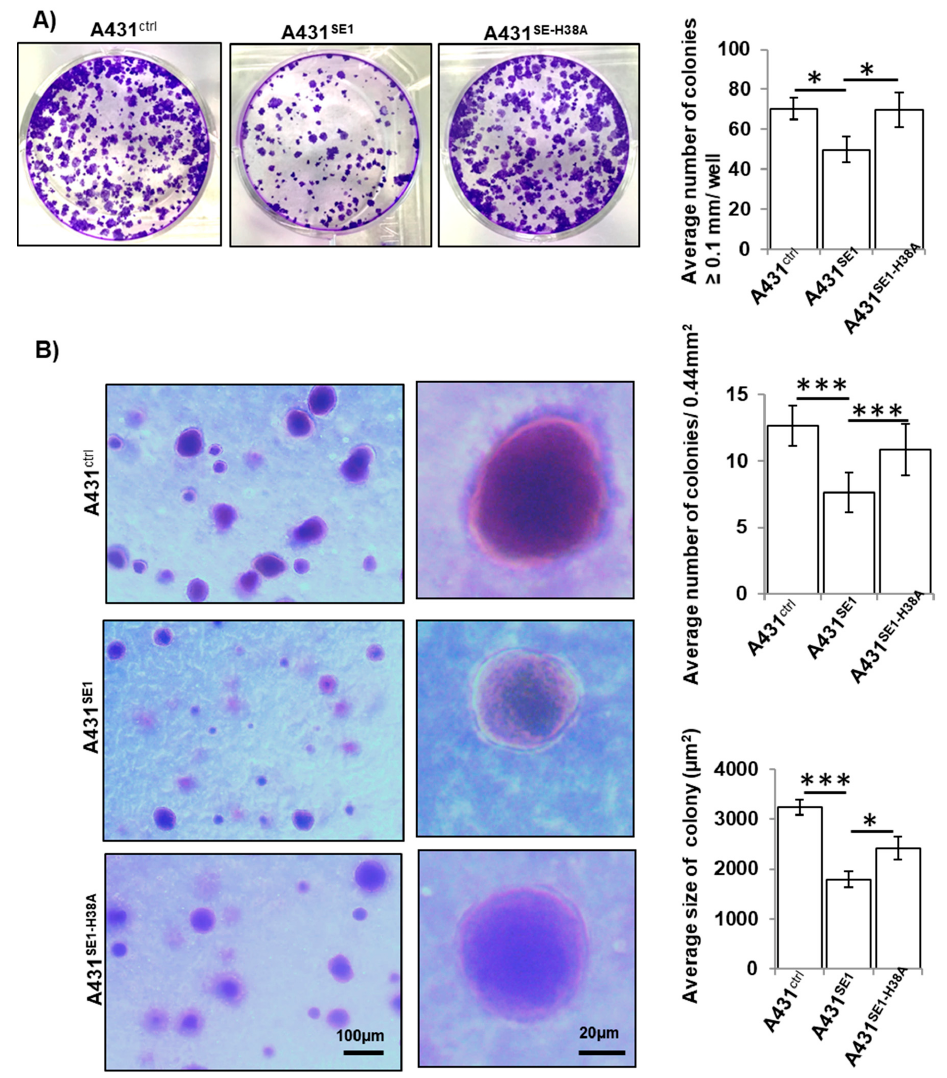
Figure 2. CDC42SE1 inhibits colony formation and growth of A431 cells in soft agar. ( A ) A431 cells (A431 Ctrl , A431 SE1 , and A431 SE1-H38A ) cells were grown for 14 days before being stained with 0.05% crystal violet and imaged. Graph represents the average number of colonies/well. ( B ) A431 cells (A431 Ctrl , A431 SE1 , and A431 SE1-H38A ) were grown in 0.6% agar for 14 days and stained with 0.05% crystal violet and imaged. Graph represents average the number of colonies/area and average size of colonies. Images were taken with a 5× objective and 6 fields were counted for each sample (n = 3). Colony area (µm 2 ) was measured using ImageJ software. (*** p ≤ 0.001, * p ≤ 0.05).